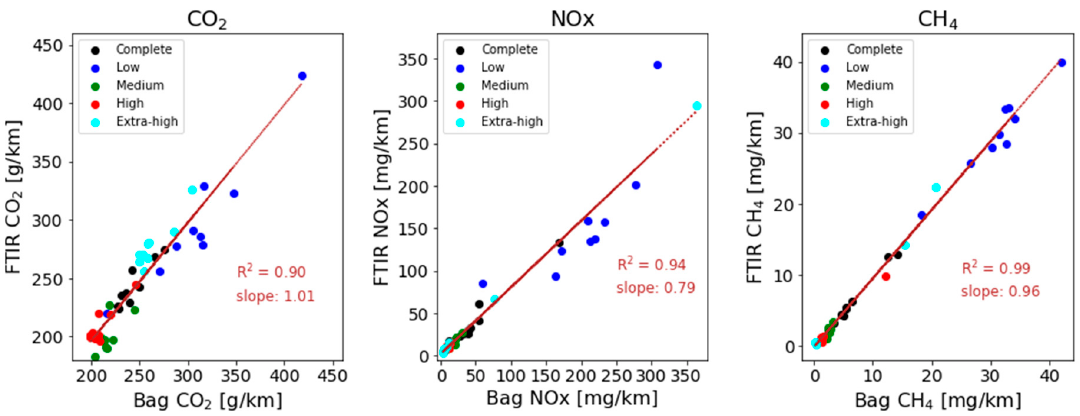
Figure A3. Scatterplot of Bag vs. FTIR distance-specific emissions for CO 2 , NO x and CH 4 for the complete laboratory WLTC tests and their respective sub-phases. Number of tests considered: 9. The brown dotted line represents the fitted line to the scatter data of each pollutant, considering all cycles and sub-phases.